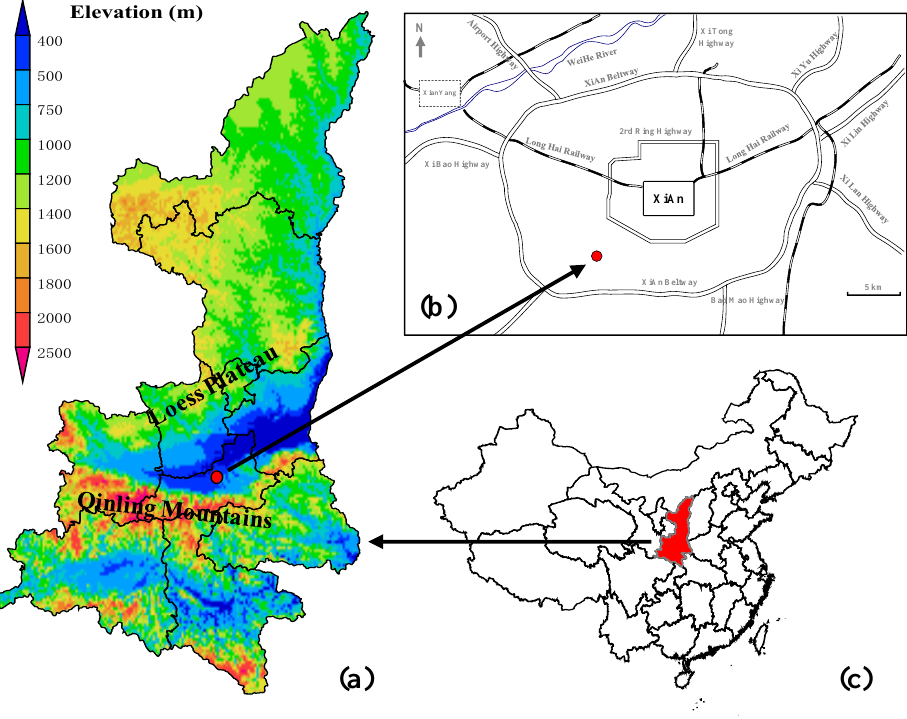
Figure 1. Location of the Xi'an observation site and its surrounding topography.